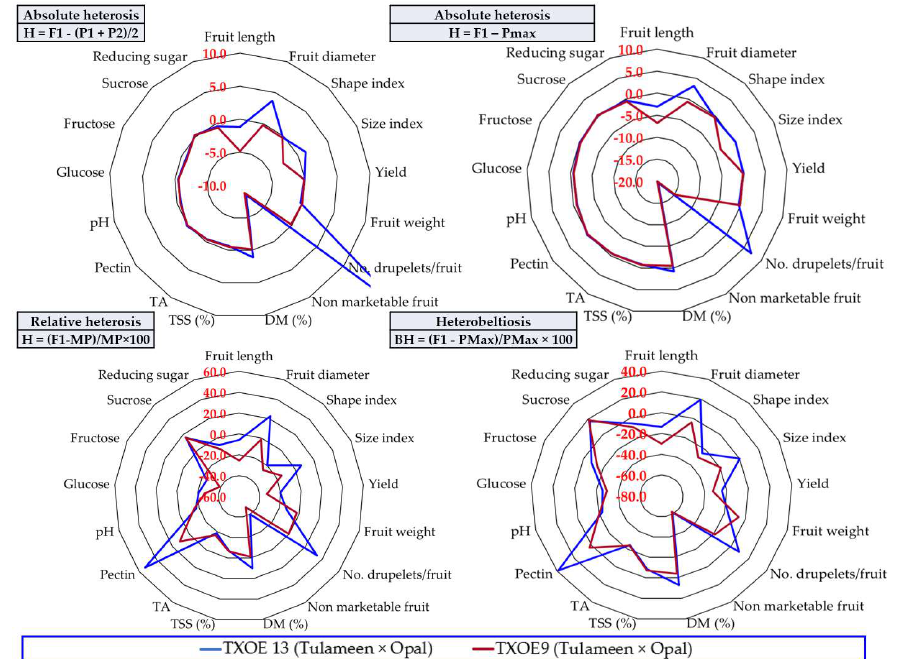
Figure 10. The heterosis effect upon the 17 analyzed characteristics in two promising selections obtained from the hybridization of Tulameen × Opal.